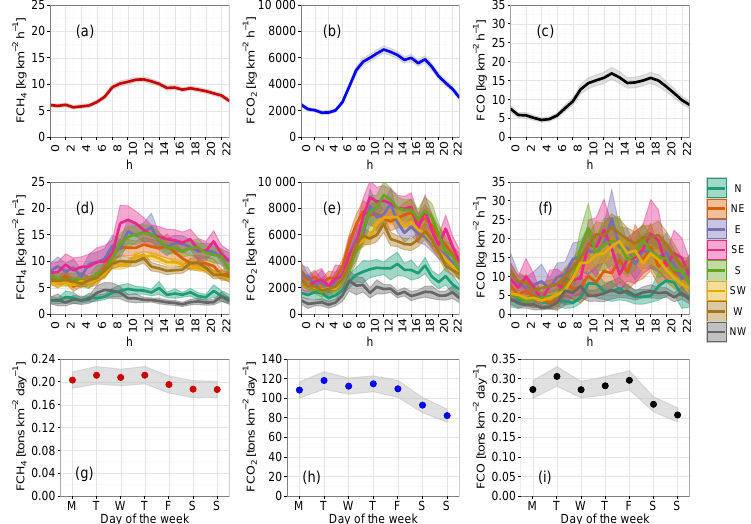
Figure 6. Fluxes of (a, d, g) methane ( F CH4 ), (b, e, h) carbon dioxide ( F CO2 ) and (c, f, i) carbon monoxide ( F CO ) observed at BT tower with a closed-path gas analyser (from 15 September 2011 to 31 December 2014): (a–c) mean diurnal patterns with 95% confidence interval (shading), (d–f) as (a–c) but segregated into wind sectors and (g–i) by day of the